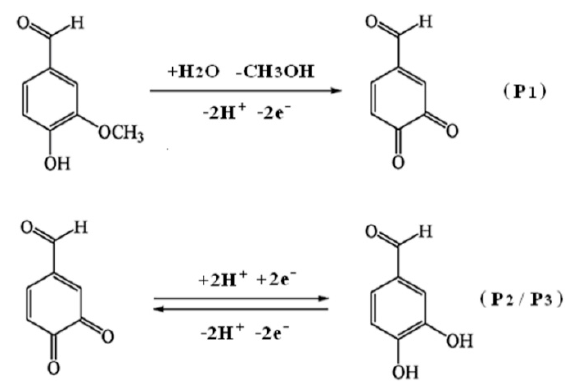
Figure 4. CVs obtained on different electrodes in 0.1 M HCl solution containing 10 µM vanillin (a: bare GCE; b: GO/GCE; c: CeO 2 /GCE; d: CeO 2 /GO/GCE; e: ERGO/GCE; f: CeO 2 /ERGO/GCE). Scan rate: 0.1 V·s − 1 . Table 1. Detailed data of CVs of 10 µM vanillin recorded at different electrodes.